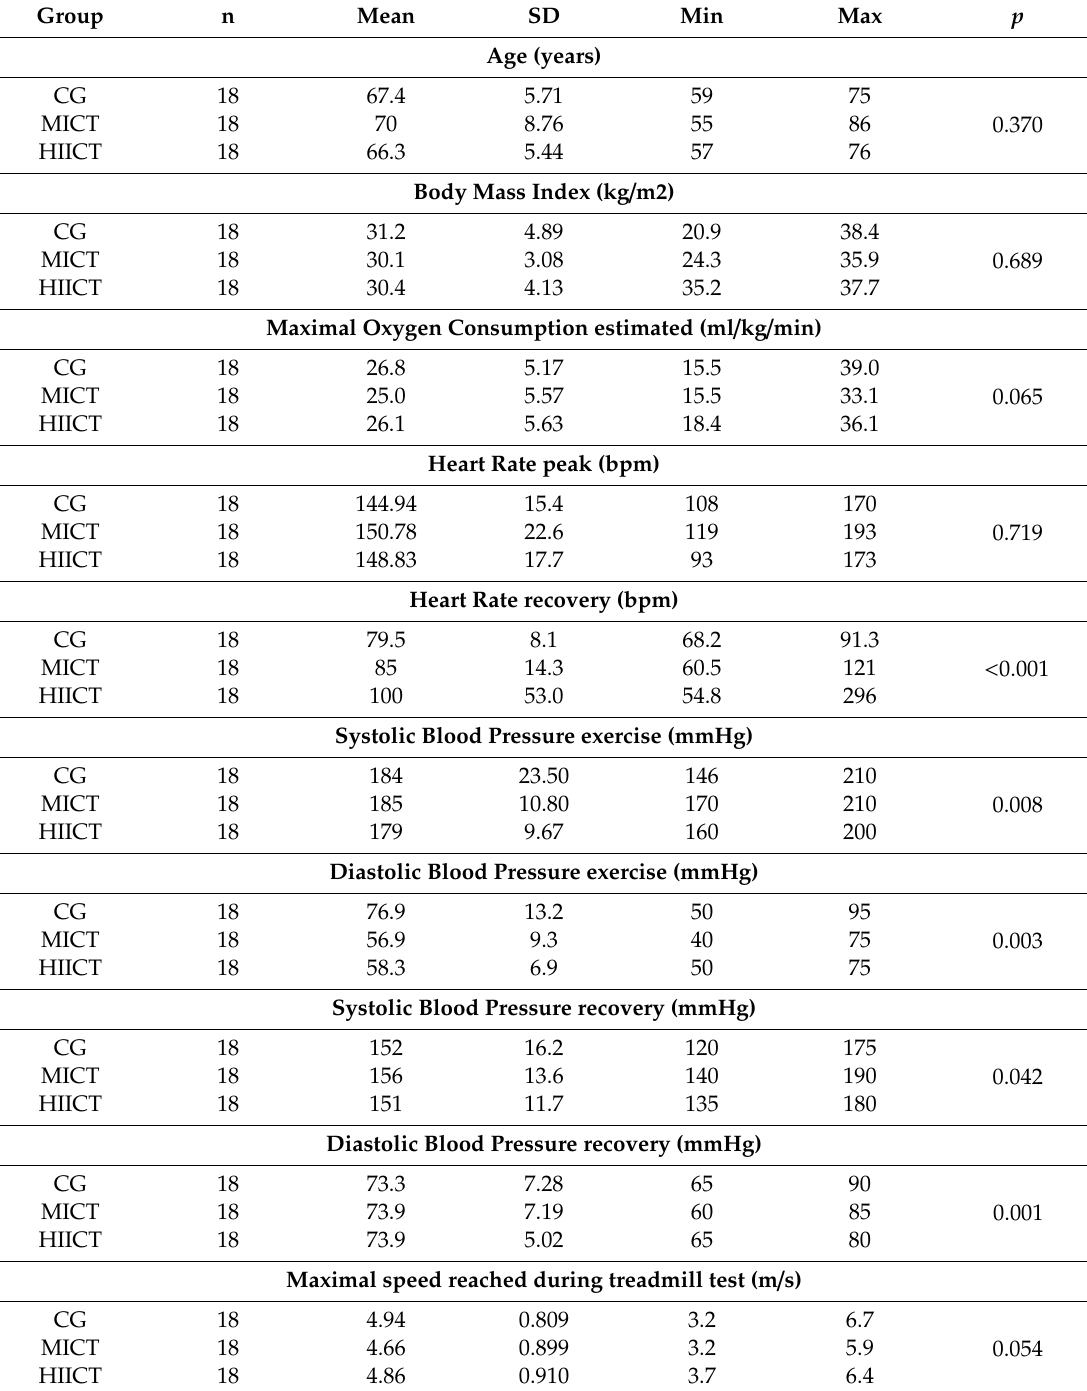
Table 1. Characteristics at baseline (n =